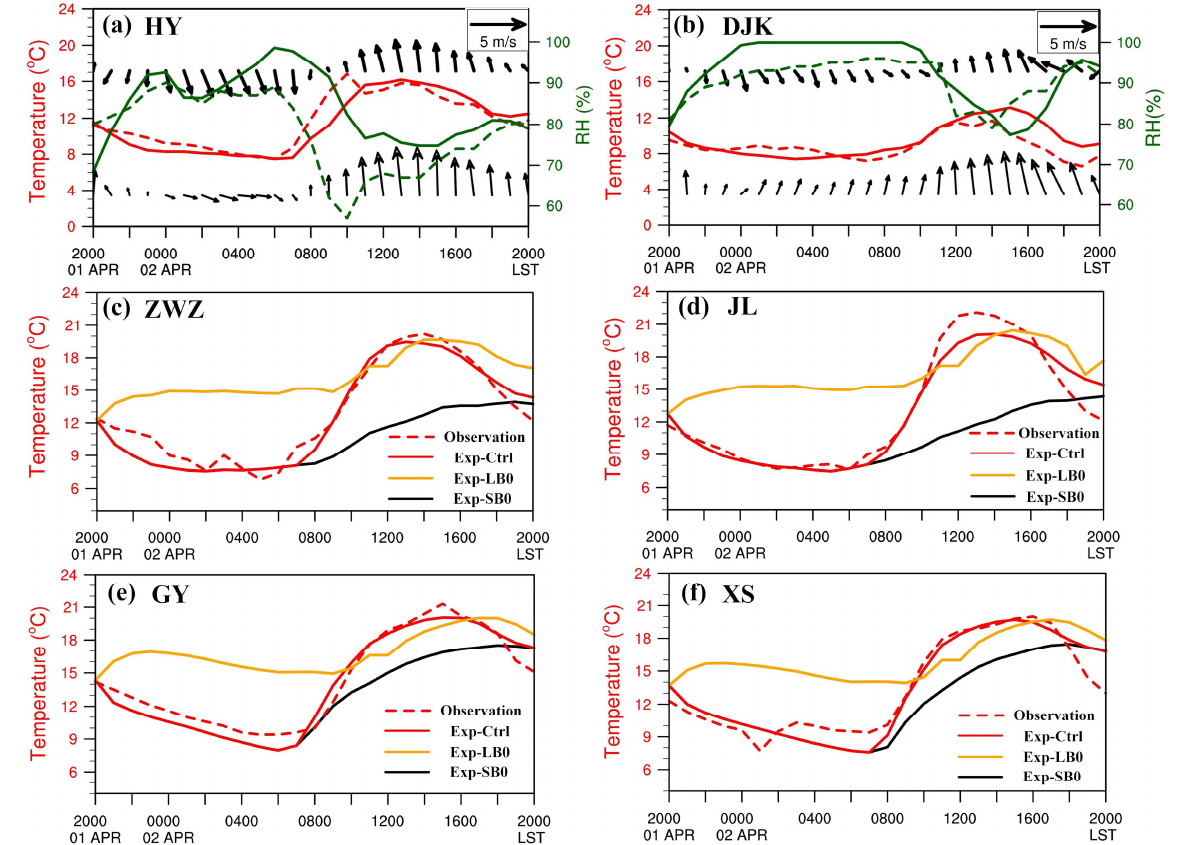
Figure 5. Comparison of the control experiment (solid line) and the observations (dash line) in 2-m temperature, 2-m RH, and 10-m wind. Thick vectors in ( a , b ) are offshore and onshore winds of the sea–land breezes. The time series of 2m-temperature of Exp-LB0 and Exp-SB0 are given in ( c , d ). The panels ( a – f ) are for the stations HY, DJK, ZWZ, JL, GY, and XS, respectively. See the definition of wind direction in Figure 4.